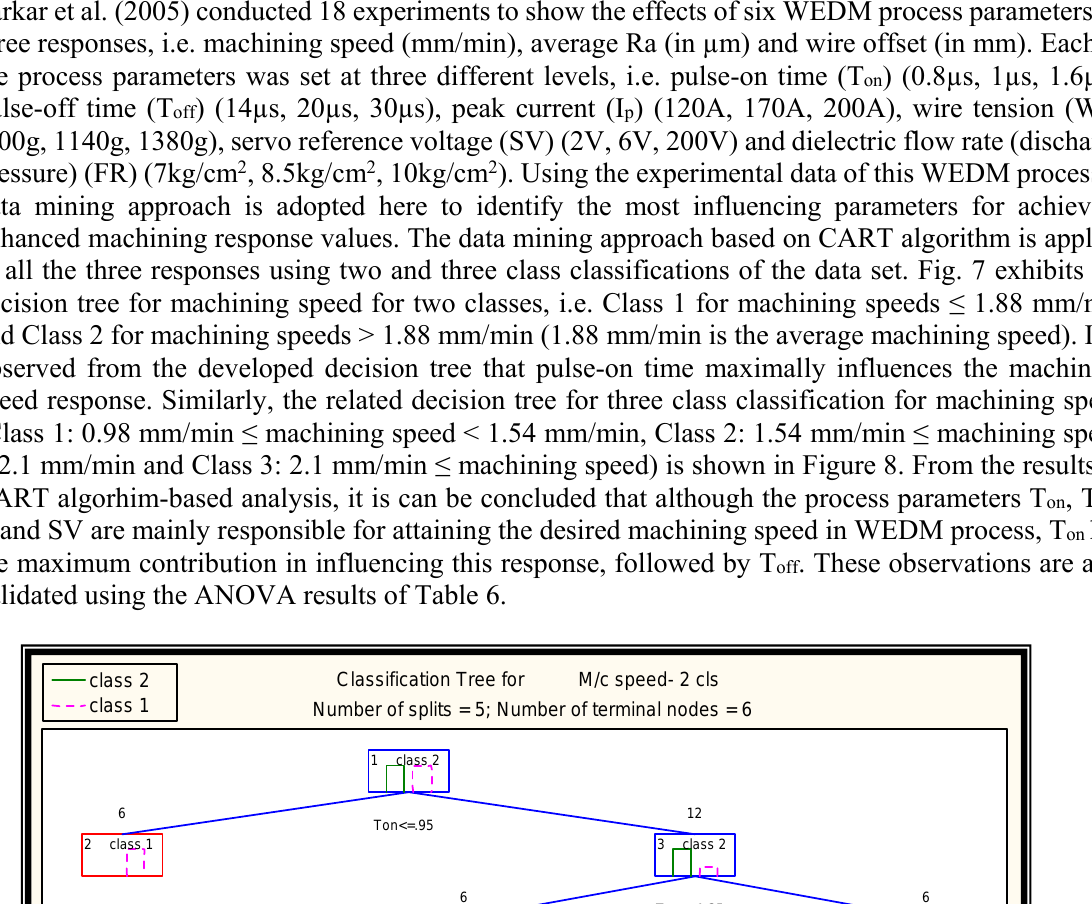
Classification Tree for M/c speed- 2 cls Number of splits = 5; Number of terminal nodes =